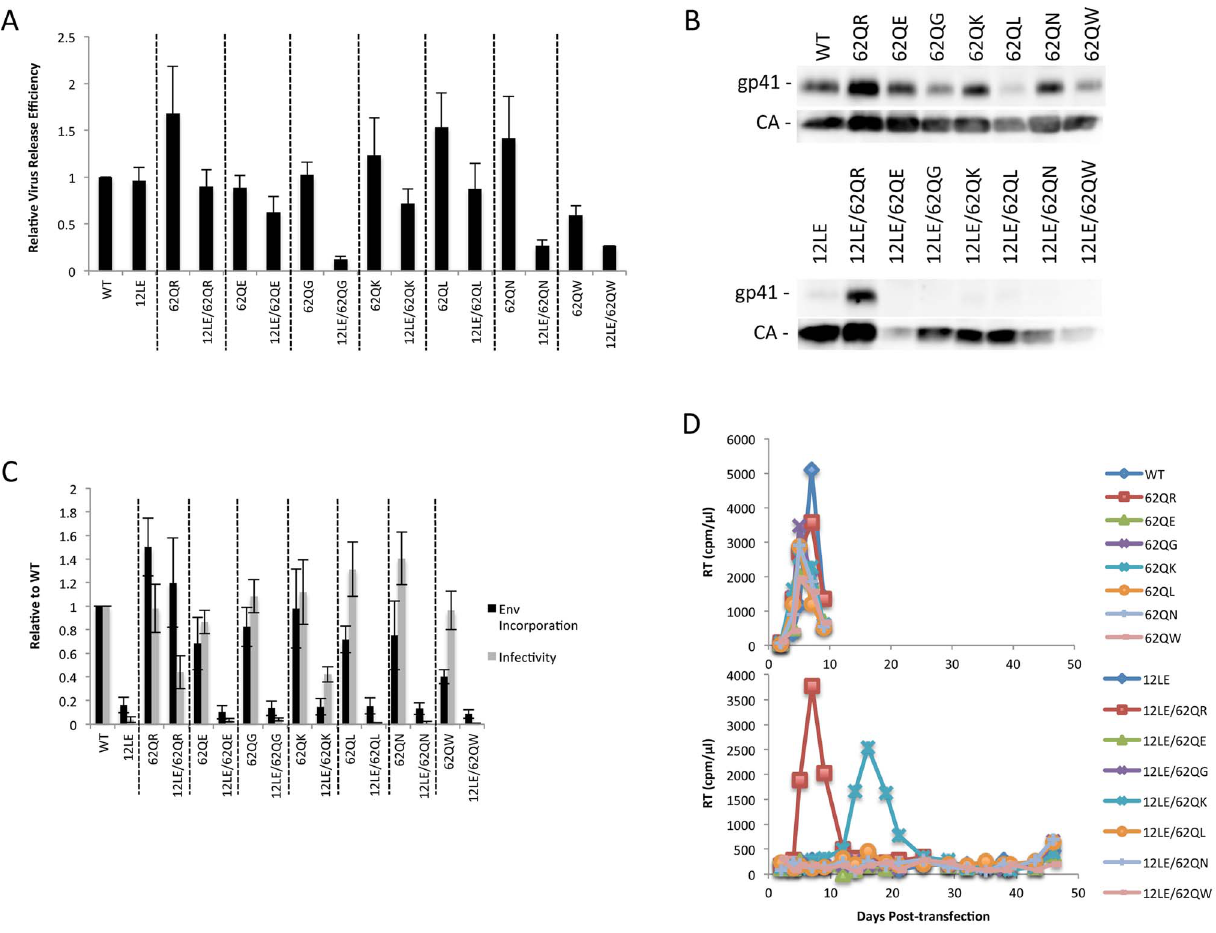
Figure 5. Vertical scanning of MA residue 62 to determine effects on Env incorporation and ability to rescue Env-incorporation- defective mutants. (A) HeLa cells were transfected with the molecular clones indicated. Virus release efficiency was determined by metabolic labeling with 35 S[Met/Cys] as described in Materials and Methods. n=3, + / 2 SEM. (B) 293T cells were transfected with the indicated molecular clones. At 24 h, supernatants were filtered then virions pelleted, lysed, and probed by western blotting for gp41 and CA. (C) Supernatants from (B) were harvested and assayed for infectivity as described in Materials and Methods. Env incorporation was determined as described in Materials and Methods. Infectivity and Env incorporation are expressed relative to the WT value. n=6, + / 2 SEM. (D) Jurkat cells were transfected with the indicated molecular clones. At 2-day intervals the cells were split and samples of media were assayed for RT activity.